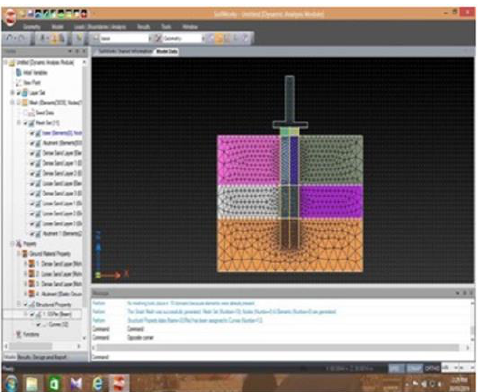
Fig.5. 2D Finite element model of soil-pile-with pile raft structure for nine pipe pile group in loose layer in-between dense layers at an eccentricity 61mm above the ground